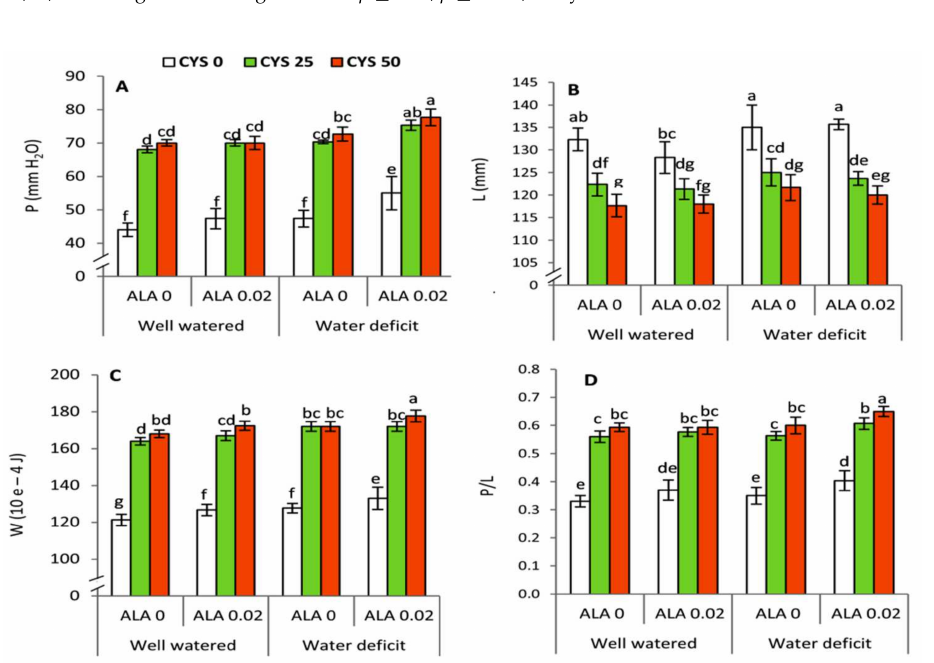
Figure 8. Effect of irrigation level, seed soaking by α -lipoic acid (ALA; 0 and 0.02 mM) and foliar application by cysteine (Cys; 0, 25 and 50 ppm) on the alveographic parameters of wheat grains. ( A ) P, ( B ) L, ( C ) W, ( D ) P/L. For each parameter, the mean values ± SD followed by a different